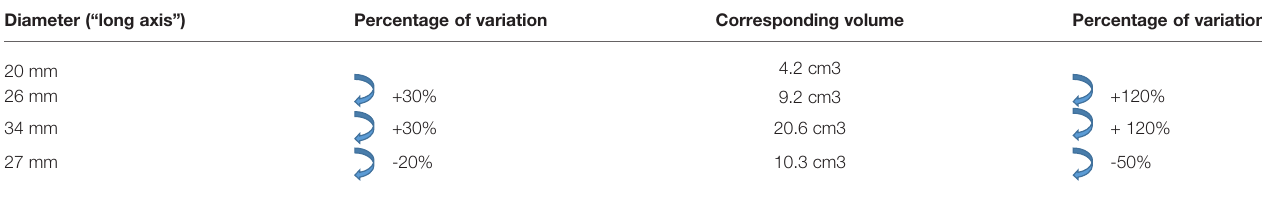
TABLE 2 | Relationship between diameter and corresponding volume.